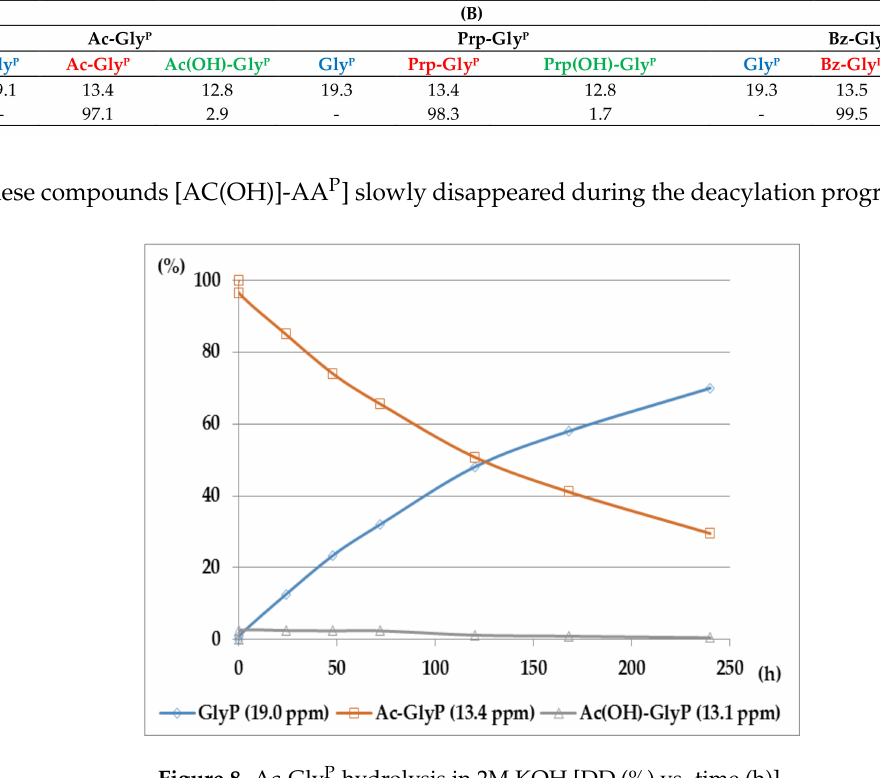
Figure 8. Ac-Gly P hydrolysis in 2M KOH [DD (%) vs. time